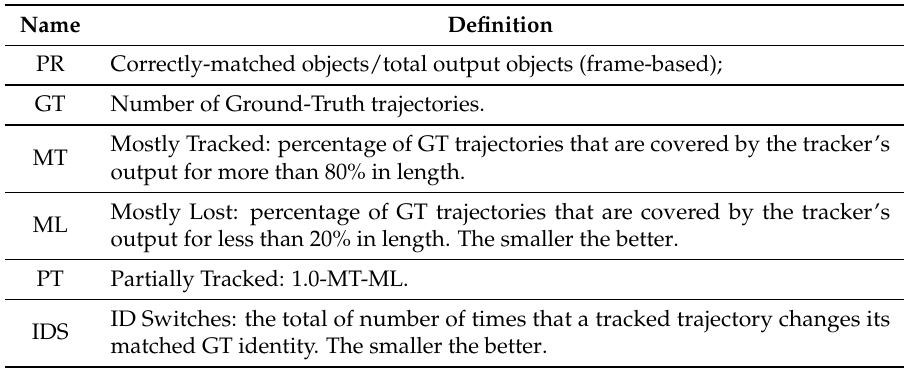
Table 3. Evaluation metrics [46]. PR, Precision.